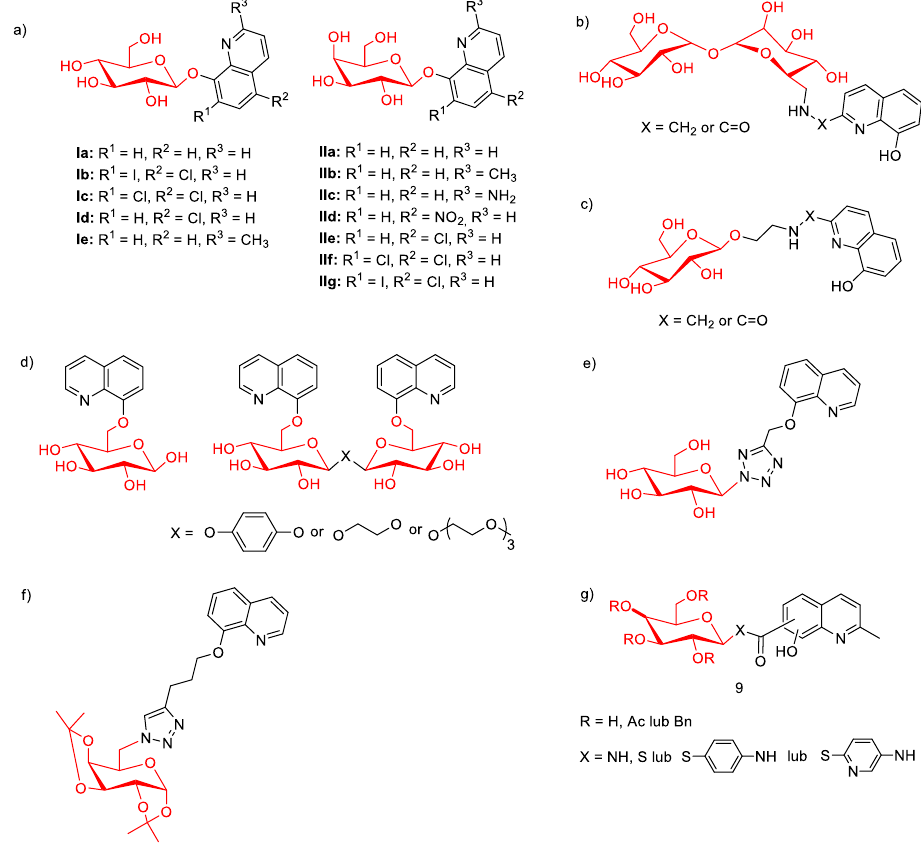
Figure 8. 8-Hydroxyquinoline glycoconjugates ( a – g